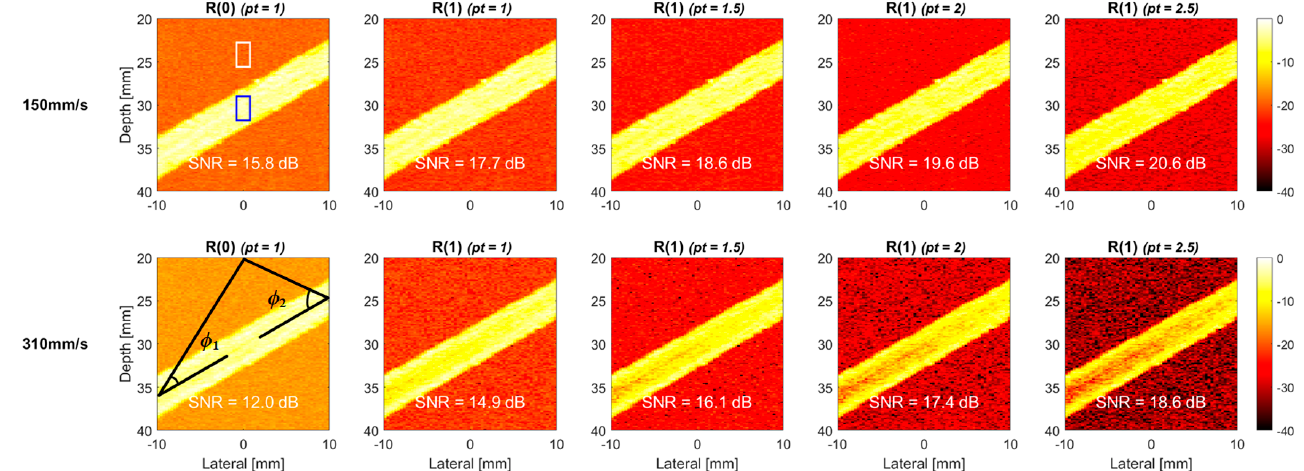
Figure 7. Simulated TMAS power Doppler images of longitudinal-view flow phantom for R(1) images with the pt values of 1.0, 1.5, 2.0 and 2.5, respectively, from left to right. R(0) image is also provided as a reference. The flow velocity is 150 mm/s ( upper ) and 310 mm/s ( lower ). The inclined angle of the flow vessel is 30°.